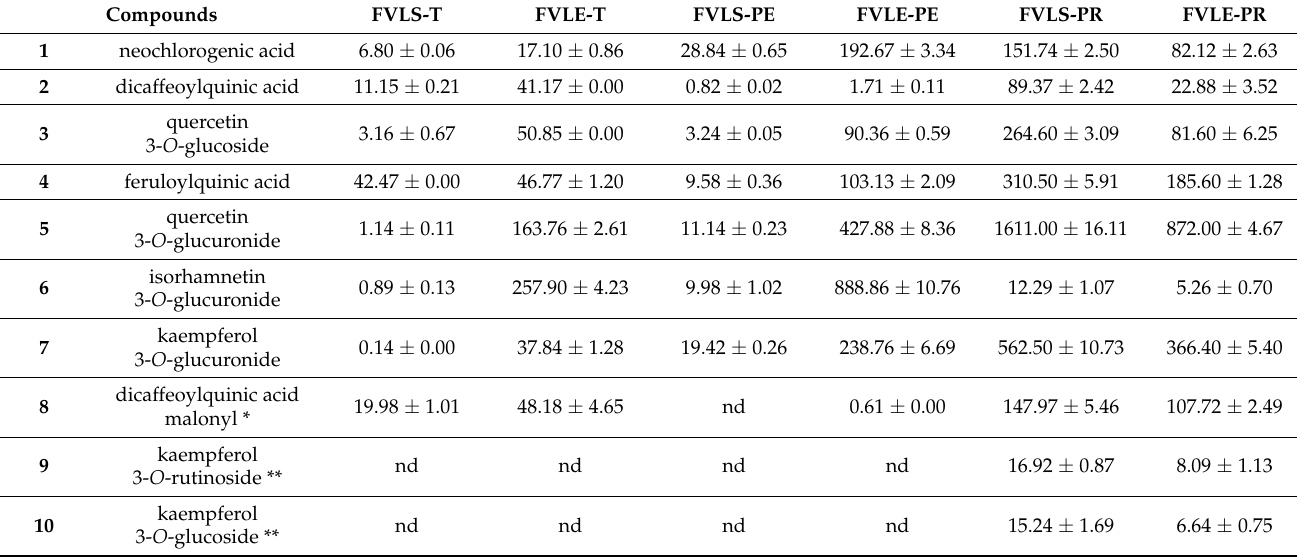
Table 2. Quantitative results obtained from the analyses of selected phenolic compounds in the F. vulgare waste of different cultivars using UHPLC-ESI-QTRAP-MS/MS analyses in MRM